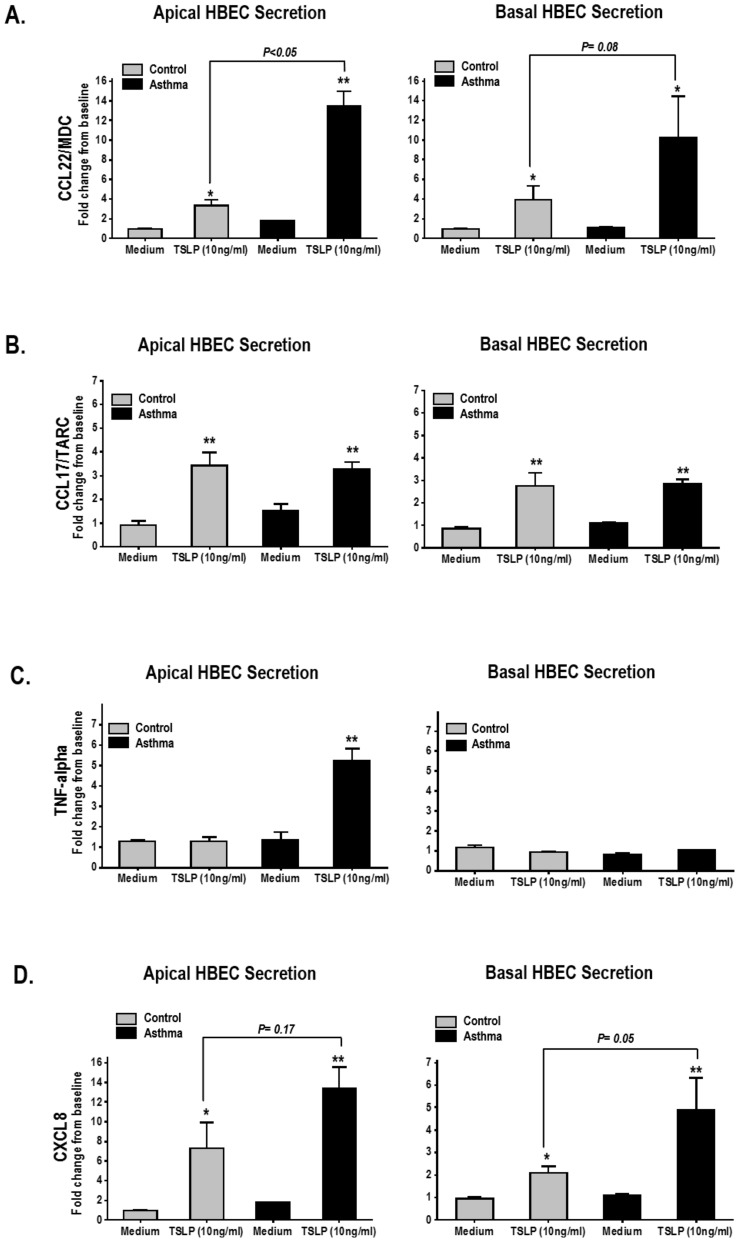
Bilateral TSLP-induced secretion of Th2-related chemokines and pro-inflammatory mediators in HBEC.CCL22/MDC (A),CCL17/TARC (B), TNF alpha (C) and CXCL8 (D) secreted by ALI-differentiated HBEC treated with TSLP (apical 10 ng/ml×48 h). Bars represent means ± SE of triplicate values from 3 experiments done with cells from 3 controls and 3 asthmatic donors. Results are expressed as fold increase from baseline relative to control values (medium alone). **P<0.01, *P<0.05.